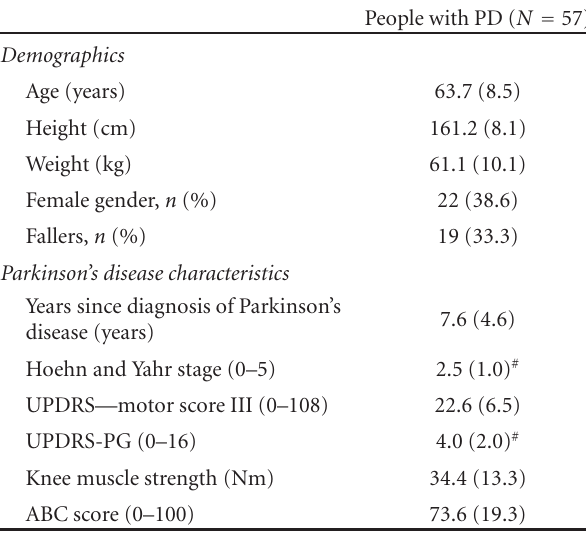
Table 1: Subject